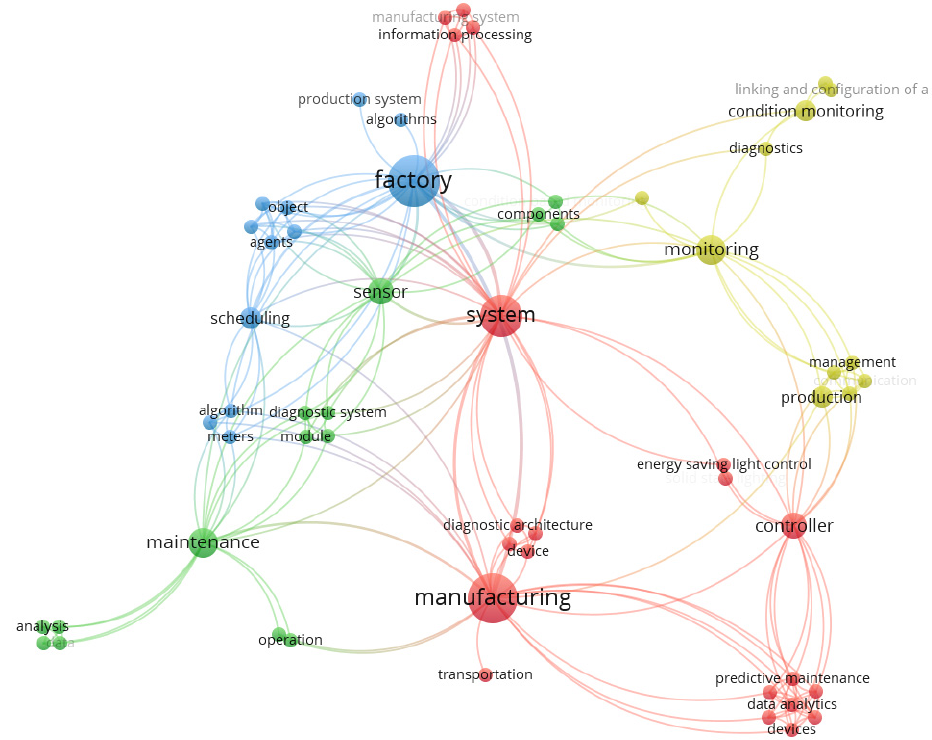
Figure 11. Analysis of keywords “smart” and “intelligent”.